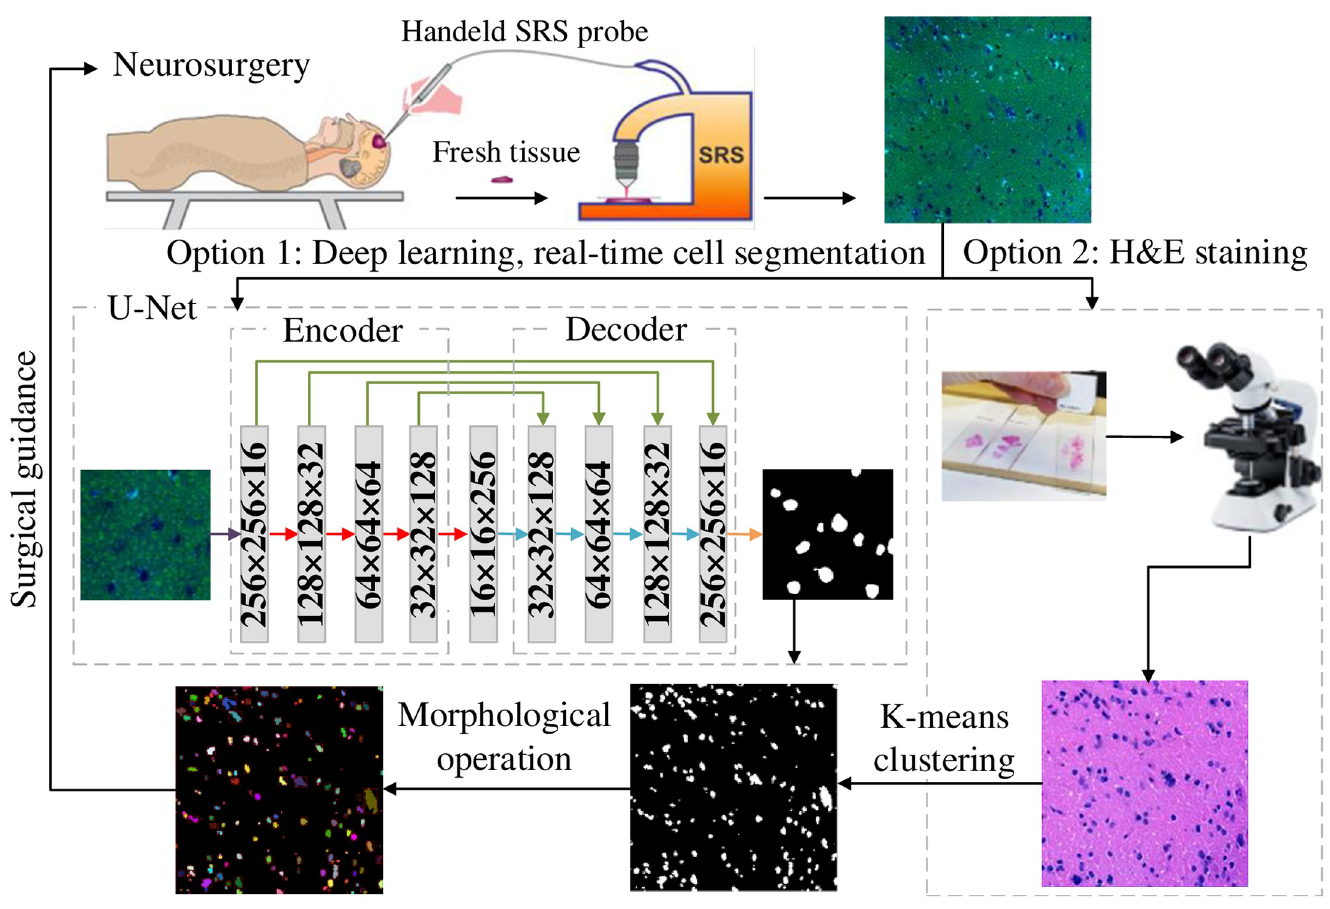
Fig 2. Overview of the cell counting